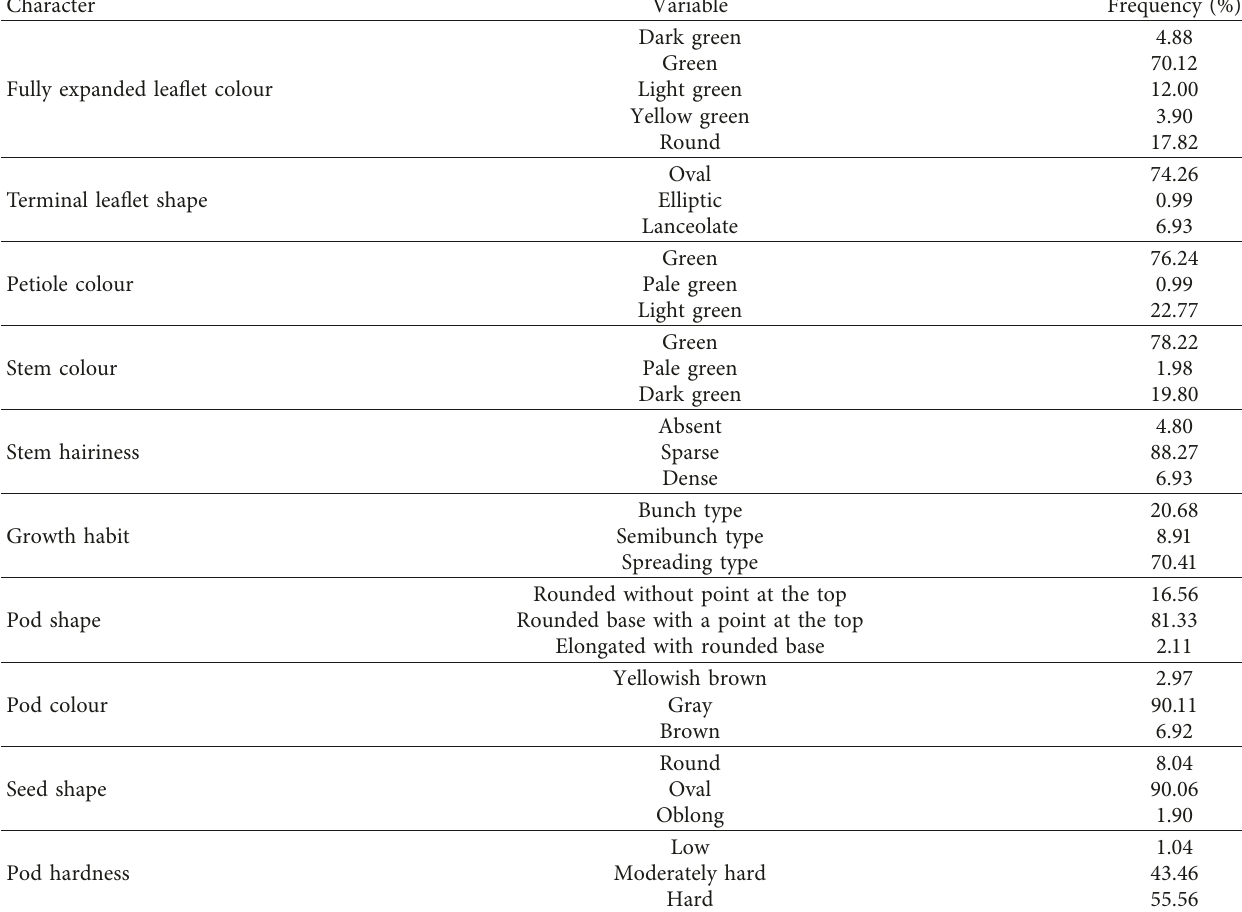
Table 1: Frequencies of qualitative characters studied in 20 Bambara nut